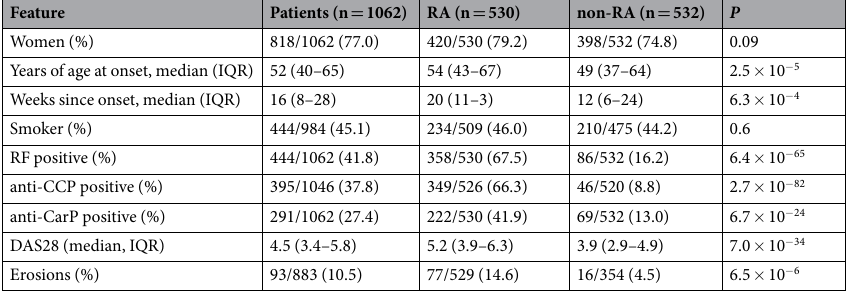
Table 1. Clinical and serological features of the EA patients. Characteristics of the EA patients as a whole and stratified as RA and non-RA at the end of the two-year follow-up. P values correspond to the comparison of the two strata with t-student or chi-squared tests. IQR = interquartile